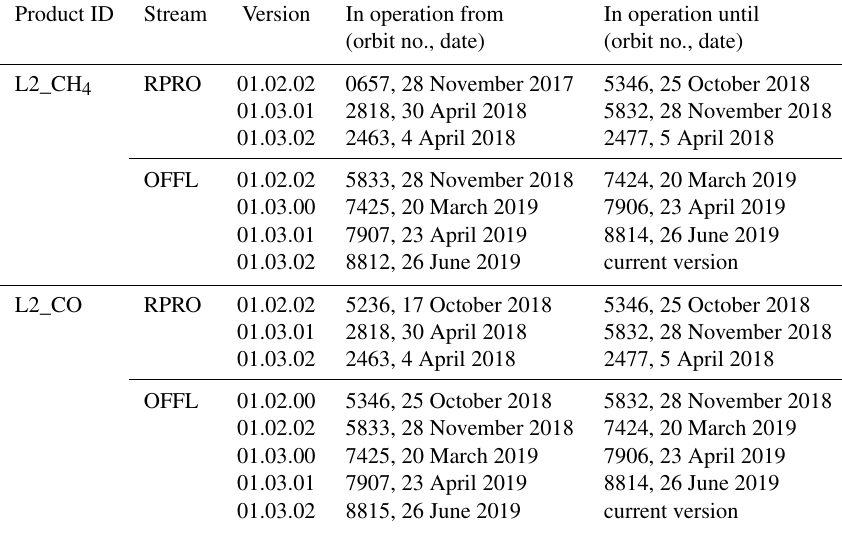
Table 1. S5P operational CH 4 RPRO and OFFL data versions and CO RPRO and OFFL data versions used in the present work. Product ID Stream Version In operation from In operation until (orbit no., date) (orbit no.,